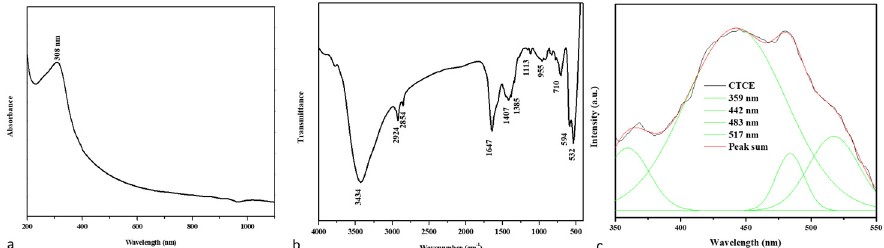
Figure 1. An analysis of the spectra of CuO-TiO 2 -chitosan-escin nanocomposites. The UV-vis spectrum of nanocomposites ( a ). FTIR transmittance vs. wavenumber plot of nanocomposites ( b ). Photoluminescence spectra from nanocomposites ( c ).